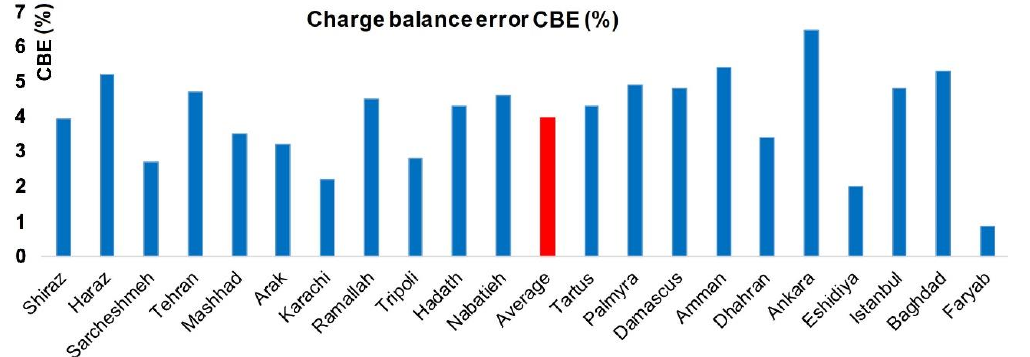
Figure 3. The variations in CBE (%) calculated for the precipitation analyses in the studied stations across the Middle East.